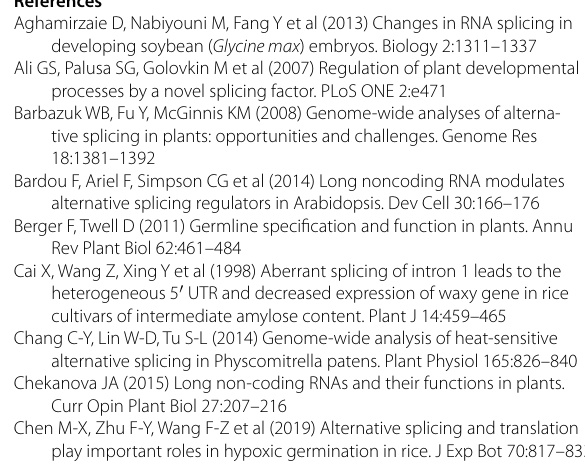
Table S5 . Primers used in the luciferase assay in